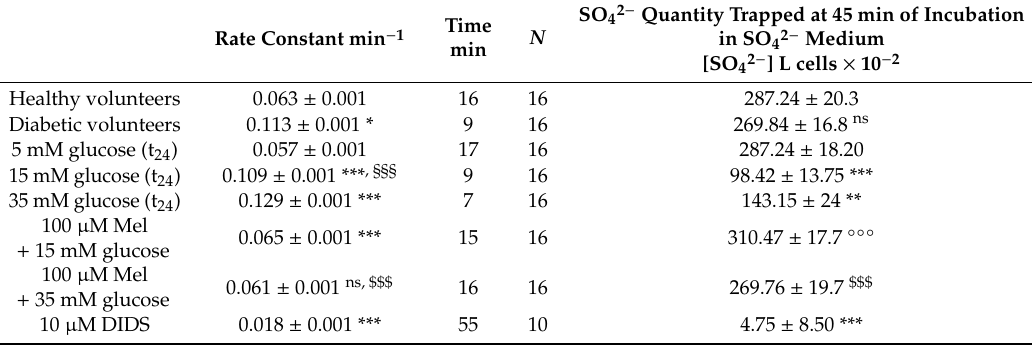
Table 1. Rate constant for SO 42 − uptake and SO 42 − quantity trapped in both diabetic and glucose-treated erythrocytes. Data are presented as means ± SEM from separate n experiments, where ns versus 5 mM glucose (t 24 ) (control) and healthy volunteers; * p < 0.05 versus healthy volunteers; ** p < 0.001 versus control; *** p < 0.001 versus control; §§§ p < 0.001 significative di ff erent versus 35 mM glucose ◦◦◦ p < 0.001 significant versus 15 mM glucose (t 24 ) and $$$ p < 0.001 significant versus 35 mM (t 24 ); glucose (t 24 ) as determined by one-way ANOVA followed by Bonferroni’s post-hoc